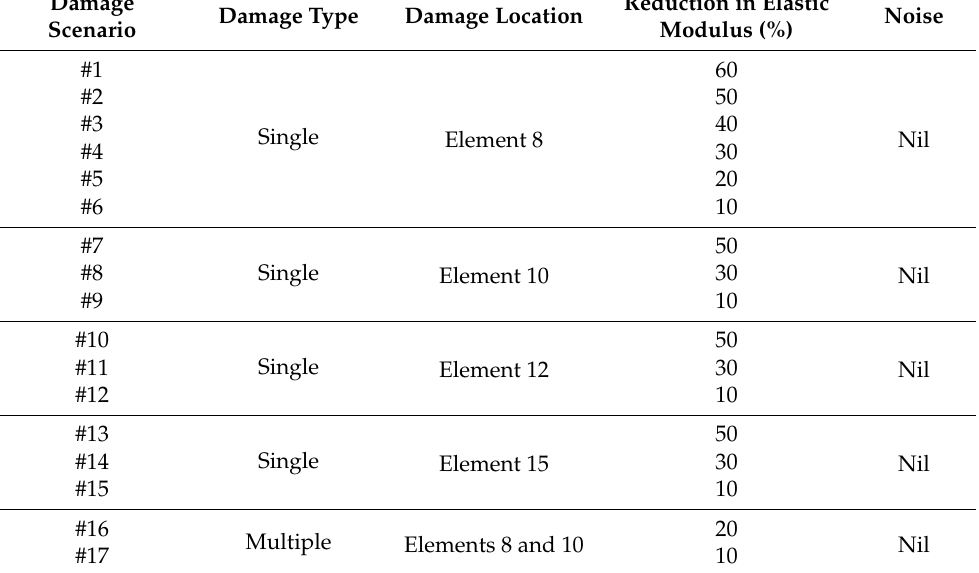
Table 3. Different damage scenarios.